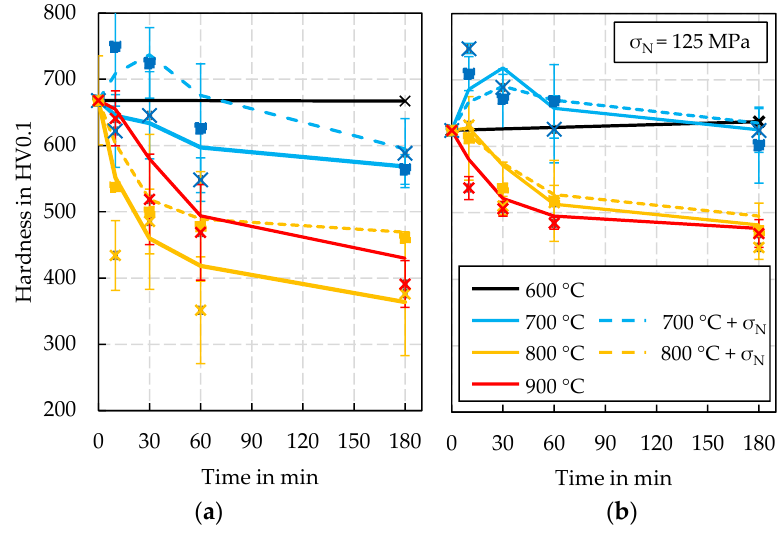
Figure 11. Results of the isothermal tempering tests: ( a ) 32 h PN, ( b ) 64 h PN.